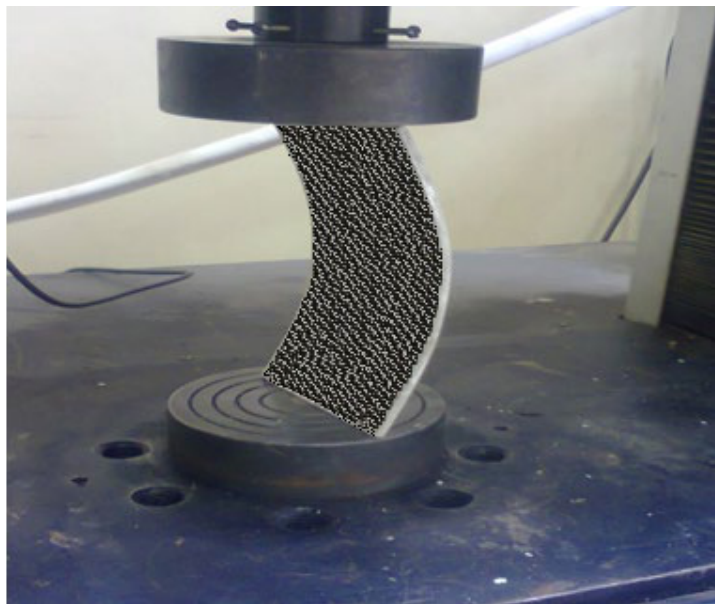
Figure 4. Rectangular plate without stiffeners.